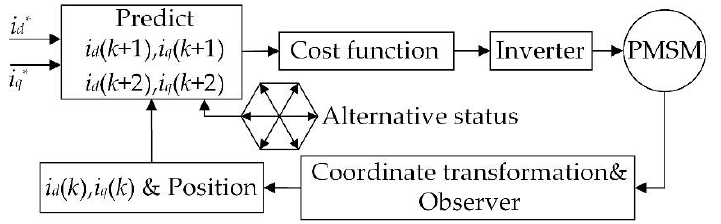
Figure 2. PMSM predictive control